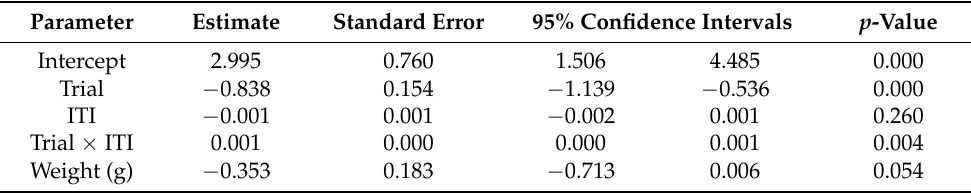
Figure 4. The effect of intertrial interval on rate of startle habituation in experiment 4. Intertrial interval is graphed on a logarithmic scale. All subjects showed a startle response when recollected after the final trial. Table 4. Experiment 4 Startle Probability Regression Analysis.